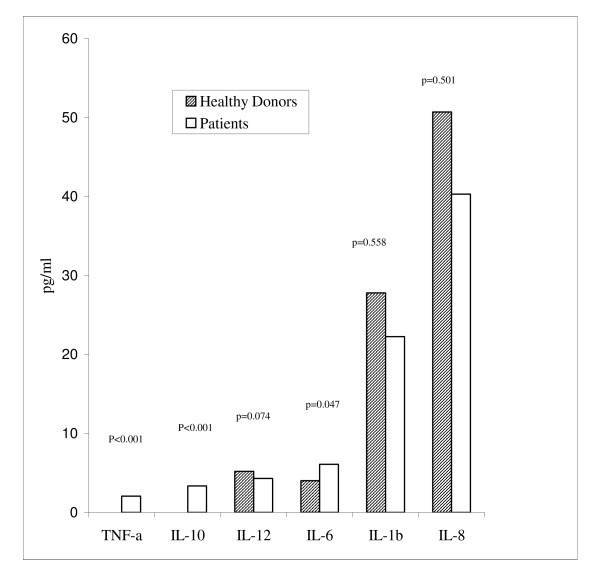
No-parametric test comparing the median levels of cytokines in healthy donors and patients.